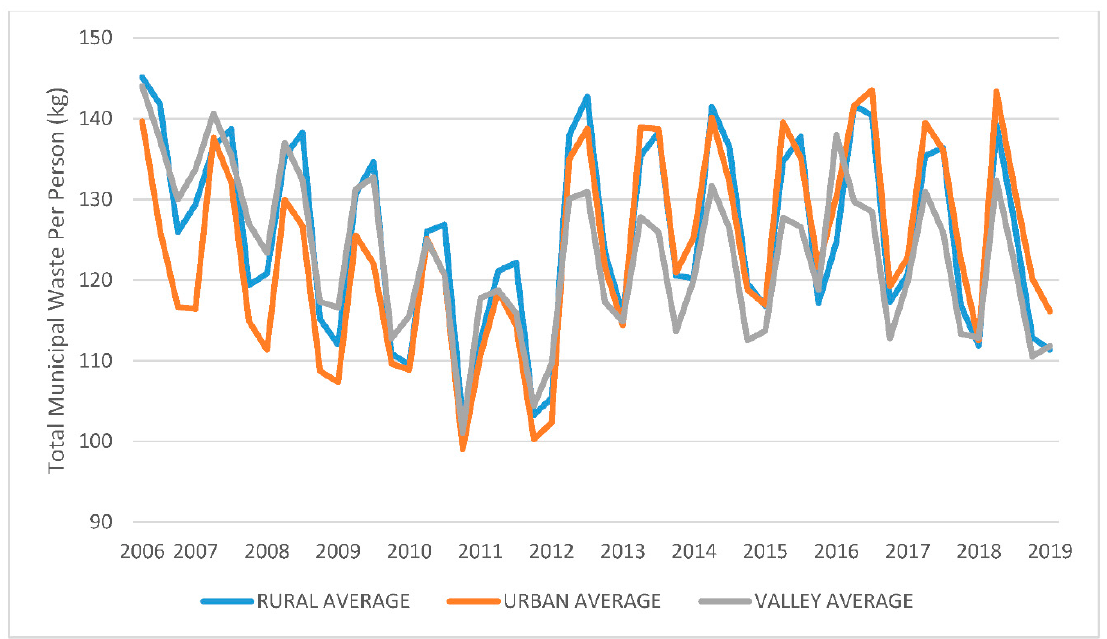
Figure A3. Total municipal waste per person for rural/urban/valley local authorities in Wales per quarter. Source WasteDataFlow.